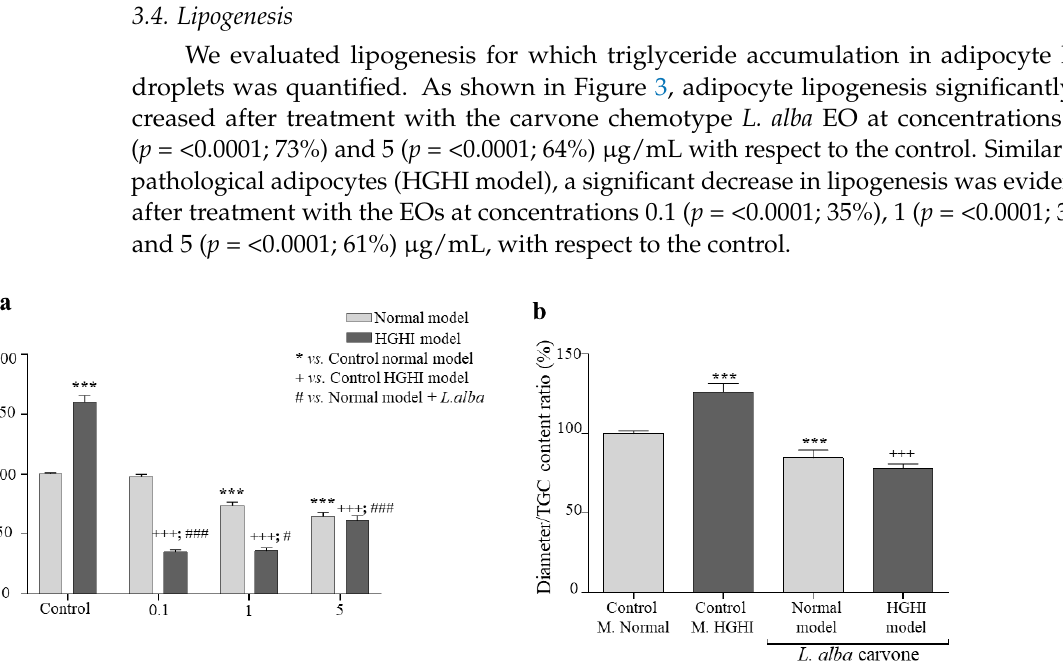
Figure 3. Lipogenesis of adipocytes treated with the carvone chemotype L. alba EO. ( a ) Intracellular accumulation of triglycerides after treatment with increasing concentrations (0.1; 1; 5 µg/mL) of the carvone chemotype L. alba EO in normal adipocytes and the pathological model of obesity and in- sulin resistance (HGHI) in vitro. ( b ) The ratio of cell diameter/TG content of adipocytes treated with 5 µg/mL of the carvone chemotype L. alba EO in normal and pathological models in vitro. *** p < 0.001 with respect to control model without EO; +++ p < 0.001 with respect to the pathological model without EO treatment; # p < 0.05; and ### p < 0.001 with respect to control model treated with EO.